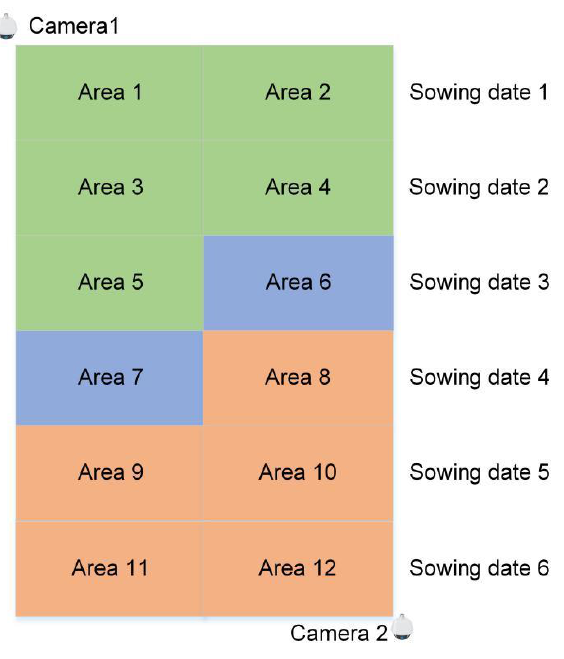
Figure 1. Distribution diagram of 12 rice experimental fields.